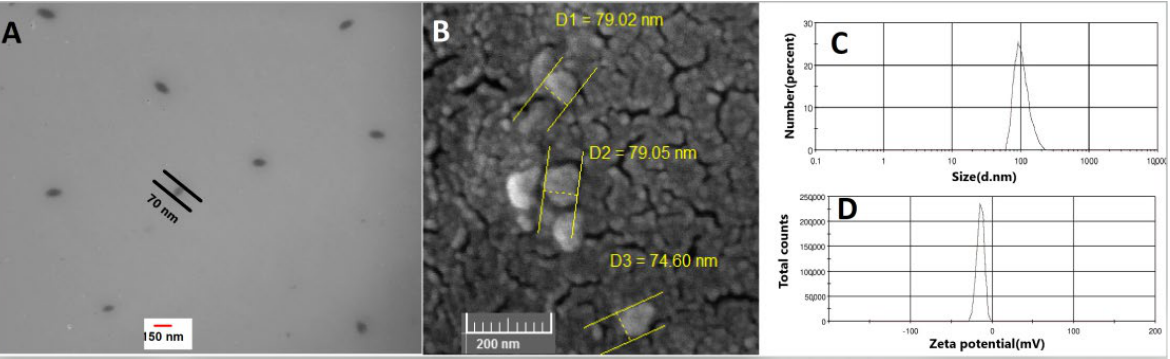
Figure 2. TEM ( A ) and SEM ( B ) photographs of iodine nanoparticles coated with amino-PEG (INP1). ( C ) Size distribution of iodine nanoparticles, ( D ) Zeta potential distribution of iodine nanoparticles.